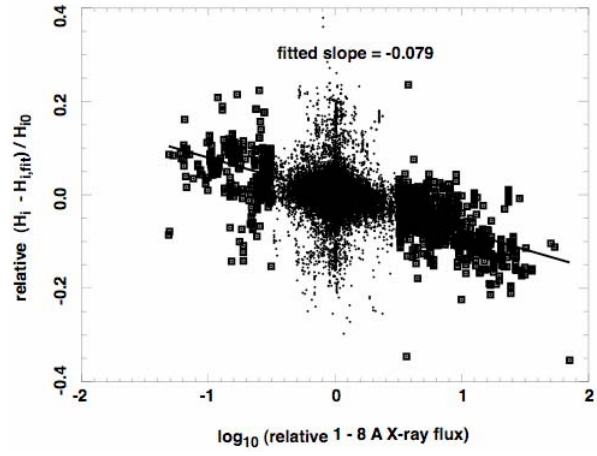
Fig. 11. Scatter plot showing dimensionless height for all heights in all clusters (after subtracting the dimensionless height of the first point in each cluster), versus the logarithm of the long-wave X-ray flux density relative to the first point in each cluster. Points whose logarithm of the flux density differs from its cluster’s first point’s flux density by more than ± 0.5 are marked by square symbols (see